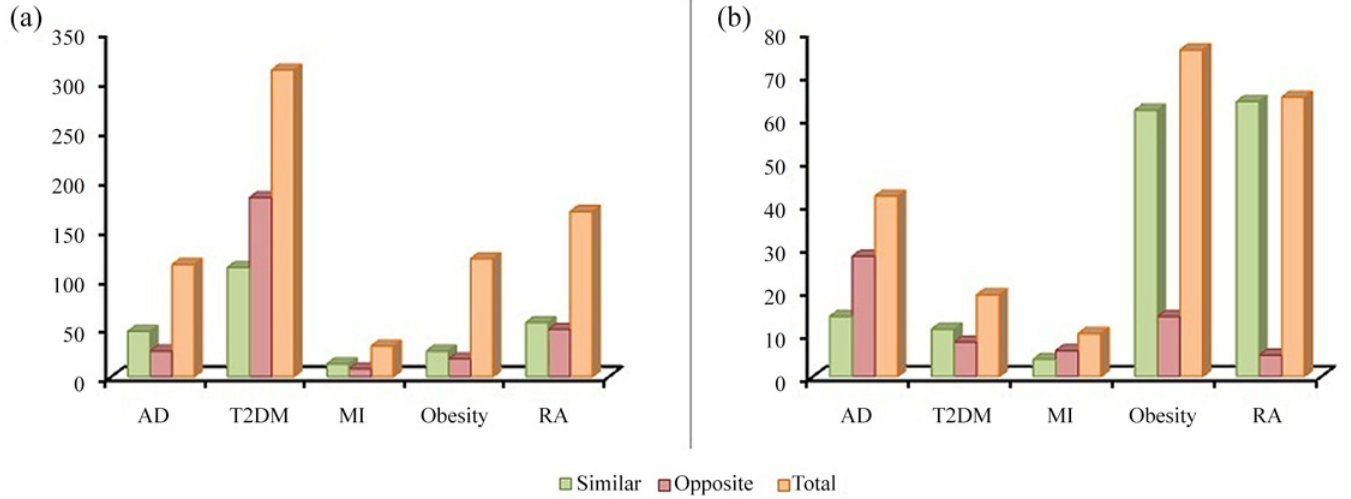
Fig 8. Number of protein regulated in similar and opposite direction. (a) Proteins upregulated (b) proteins